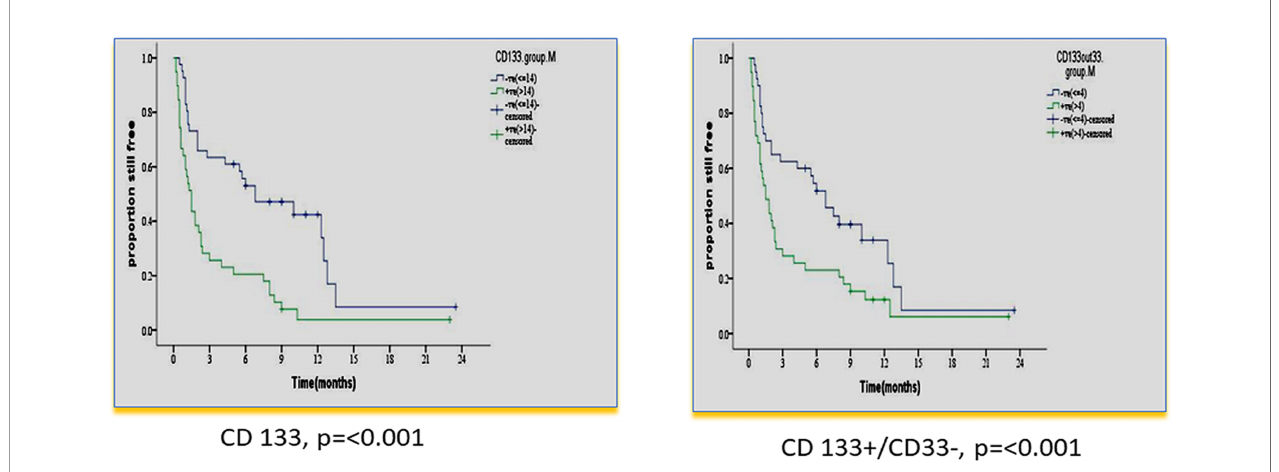
TABLE 5 | Correlation between leukemia stem cell frequency at diagnosis in 75 adult acute myeloid leukemia patients and measurable/minimal residual disease at day 14 and day 28. Parameter